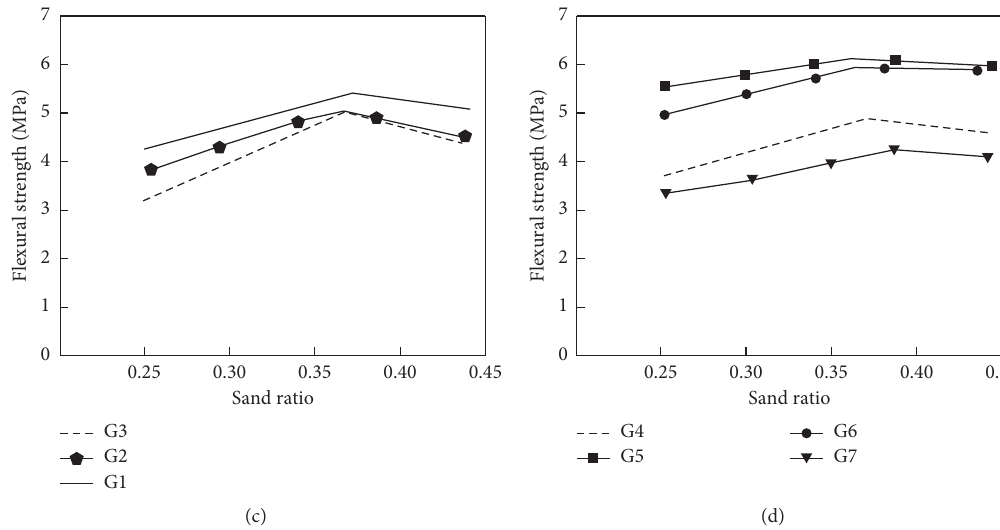
Figure 9: The variation of flexural strength of coal gangue-based polymer concrete with sand ratio. (a) Seven-days flexural strength (G1–G3). (b) Seven-day flexural strength (G4–G7). (c) 28-day flexural strength (G1–G3). (d) 28-day flexural strength